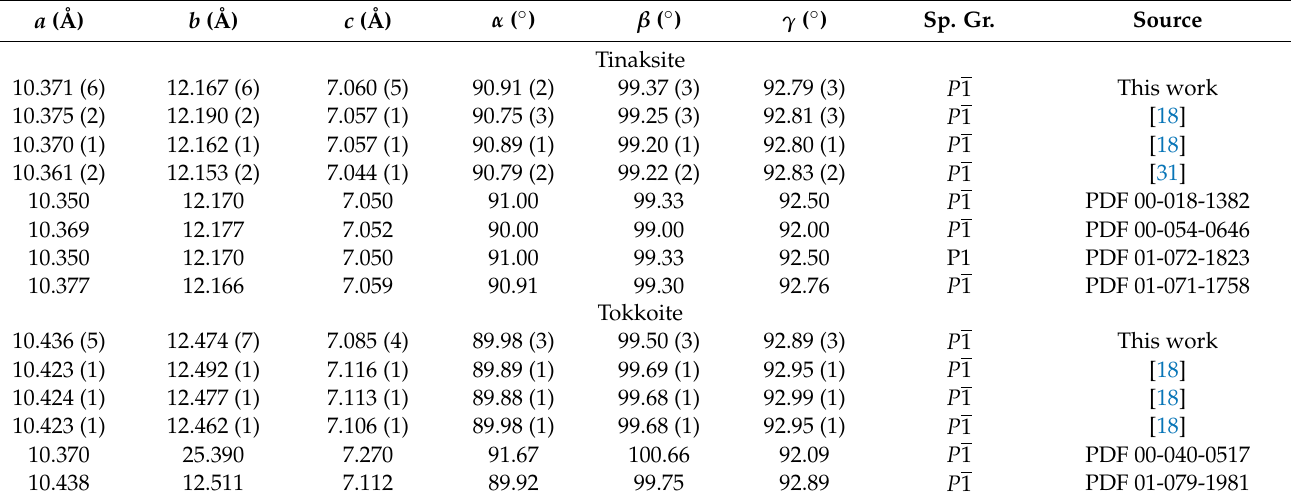
Table 1. Unit cell parameters, space group, and crystal chemical formulas of tinaksite and tokkoite as compared with the data in the literature and PDF-2 files. PDF 00–018-1382—[1], tinaksite from Murun massif, Cr K α radiation; PDF 00–054-0646—Karimova O. IGEM RAS, Moscow, Russia, ICDD Grant-in-Aid, 2002, tinaksite from the Khibiny massif, Cu K α radiation; PDF 01–072-1823—calculated from ICSD using POWD-12++ (2004), [28], tinaksite from Murun massif, Cu K α radiation; PDF 01-071-1758—calculated from ICSD using POWD-12++ (2004), [29], tinaksite from Murun massif, Cu K α radiation; PDF 00-040-0517—[2], tokkoite from Murun massif, unknown radiation; PDF 01-079-1981—calculated from ICSD using POWD-12++ (2004), [30], tokkoite from Murun